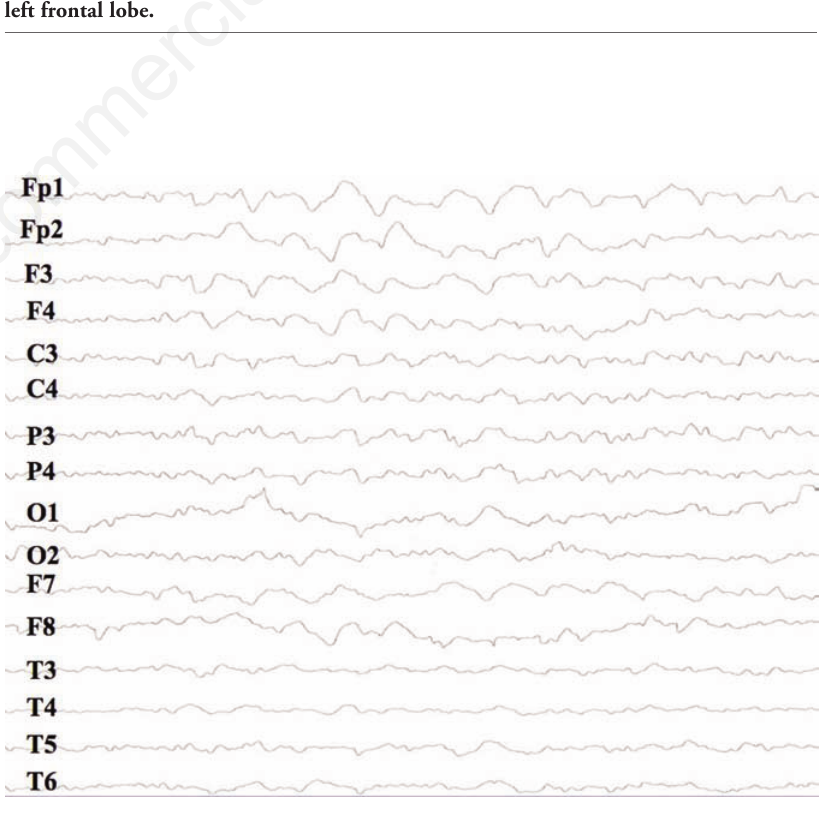
Figure 3. An electroencephalogram showed theta and delta waves in the frontotemporal regions